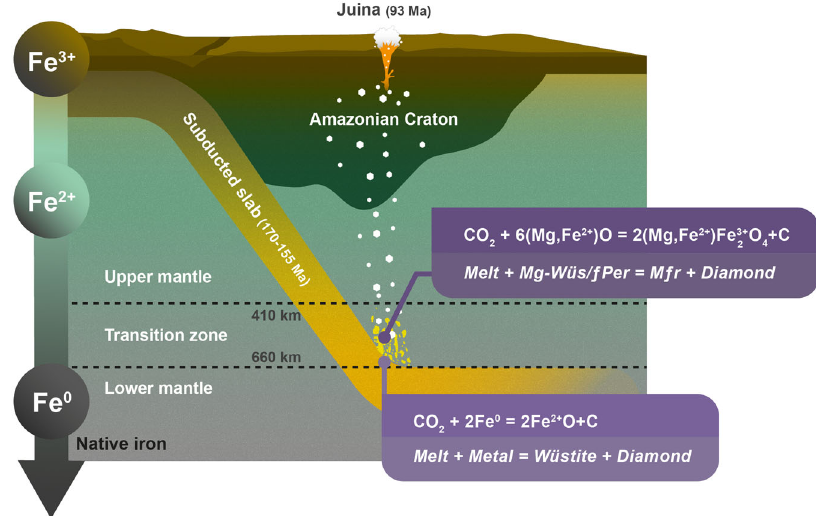
Fig. 4 | Mantle beneath the Amazonian Craton. Schematic illustration showing the formation of the magnesiowüstite-magnesioferrite mineral association in Juina